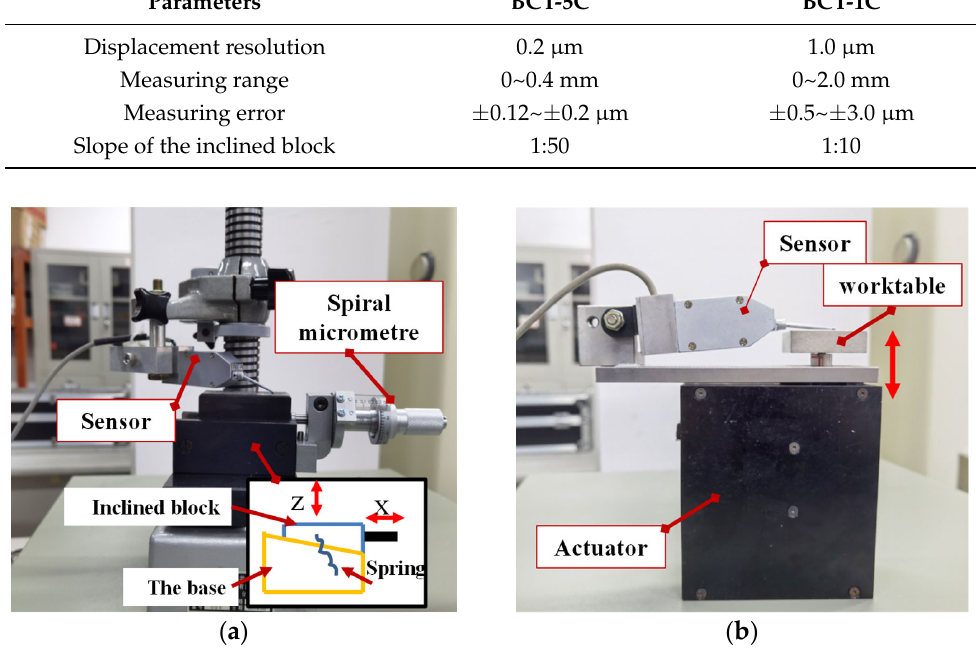
Figure 7. Sensor fixtures for time drift tests of DIFOD sensors: ( a ) BCT ‐ 1C or BCT ‐ 5C fixtures; ( b ) Micro ‐ displacement actuator.